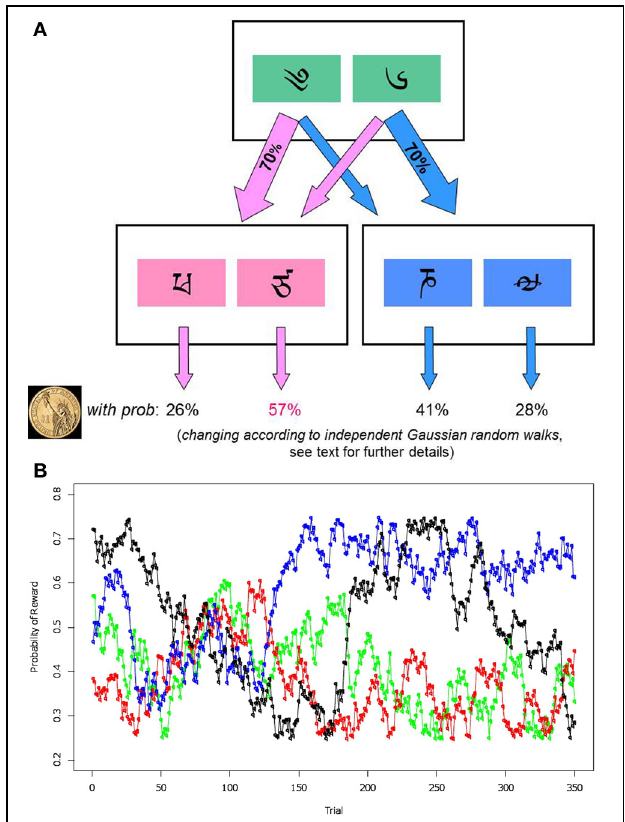
FIGURE 1 | (A) Schematic representation of the sequential task. Participants are first presented with two first-stage boxes. Each of the boxes (right or left) has a fixed probability of leading to one of the two pairs of second-stage boxes in 70% of cases, and to another pair in 30% of cases. After participants make a first-stage decision, they need to make a second choice, between the second-stage boxes. This leads them to receiving a reward, or none (depicted by a dollar image), based on which second-stage box they choose. (B) An example of reward probabilities when choosing the second-stage box. Lines of four different colors represent how probabilities change for four possible second-stage boxes. To encourage participants to learn continually, the reward probabilities diffuse according to independent Gaussian random walks.